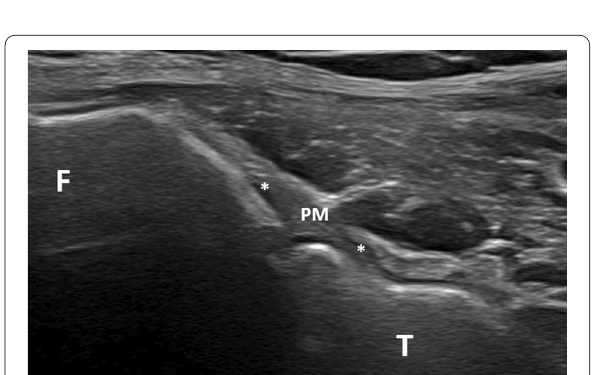
Fig. 7 Middle bundle of the posterior PTF joint (oblique and upwards plane). This bundle (PM) courses from the posterior and medial aspect of the fibular head (F) to the adjacent facet of the lateral tibial condyle which could contain small venous dots. The absence of depiction of M2 in 25% of the cases may be related to its depth, which can make it more difficult to detect than M1 on ultrasound, or to the close proximity between M1